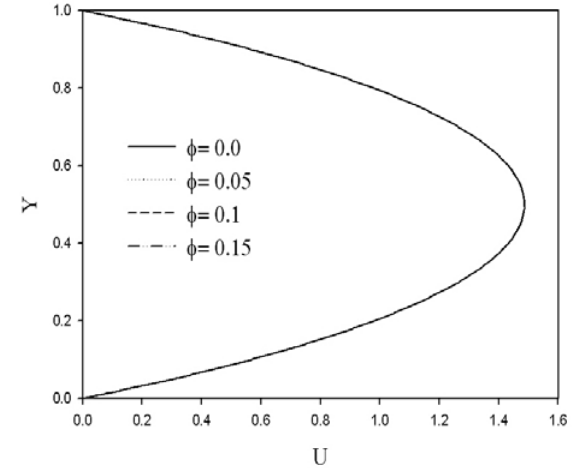
Fig. 9. Effect of volume fraction of nanoparticles ( φ ) on horizontal velocity in the fully developed region at = 0.2 and Re=100, A 0